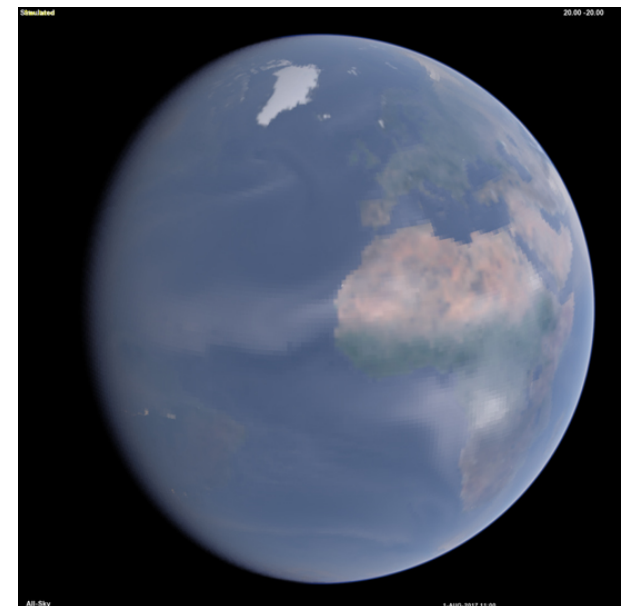
Figure 5. Simulated image of an HRRR-Smoke forecast with a smoke plume from the December 2017 California wildfires. The view is zoomed in from a perspective point at 40000km altitude.